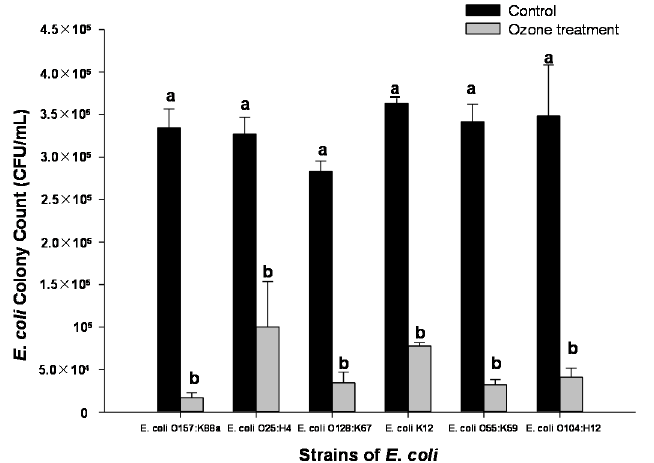
Figure 3. Impacts of ozone-enrichment on six strains of E. coli inoculated onto the surface of spinach leaves. Leaves were either treated with 1 ppm ozone concentration (grey bar) or untreated (black bar) for 10 min. Values represent means (±Standard Error) of measurements made on three independent spinach leaves per treatment. Bars with different letters are significantly different ( p < 0.05).